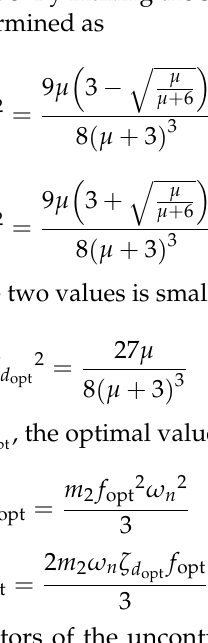
The dynamic amplification factors of the uncontrolled and controlled models for µ = 0.5 are illustrated in Figure